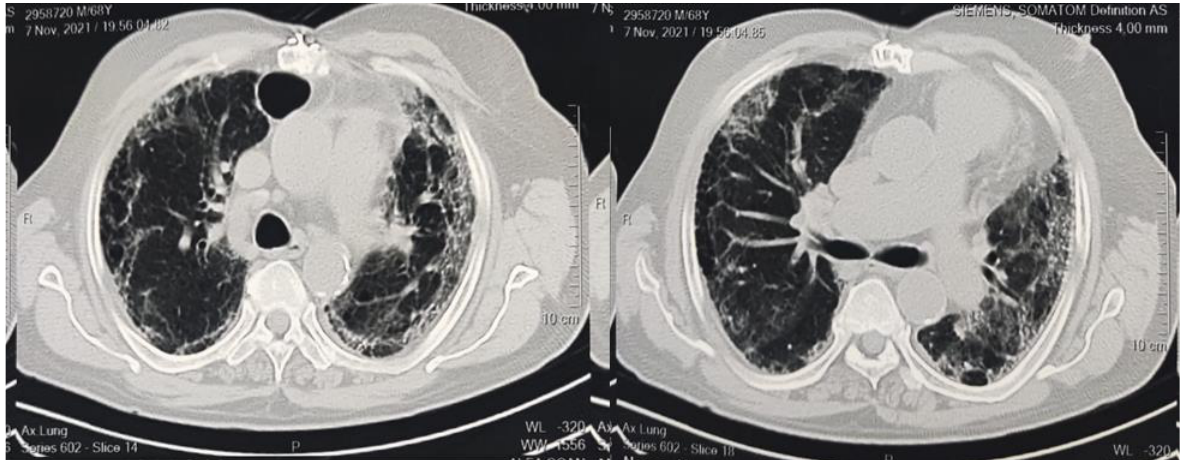
Figure 1. CT imaging indicates bilateral marked pulmonary infection with diffuse ground glass opacities, areas of air trapping, and pulmonary thickened interstitium with subsequent architectural distortion, basal bronchiectasis, and honeycombing appearance.